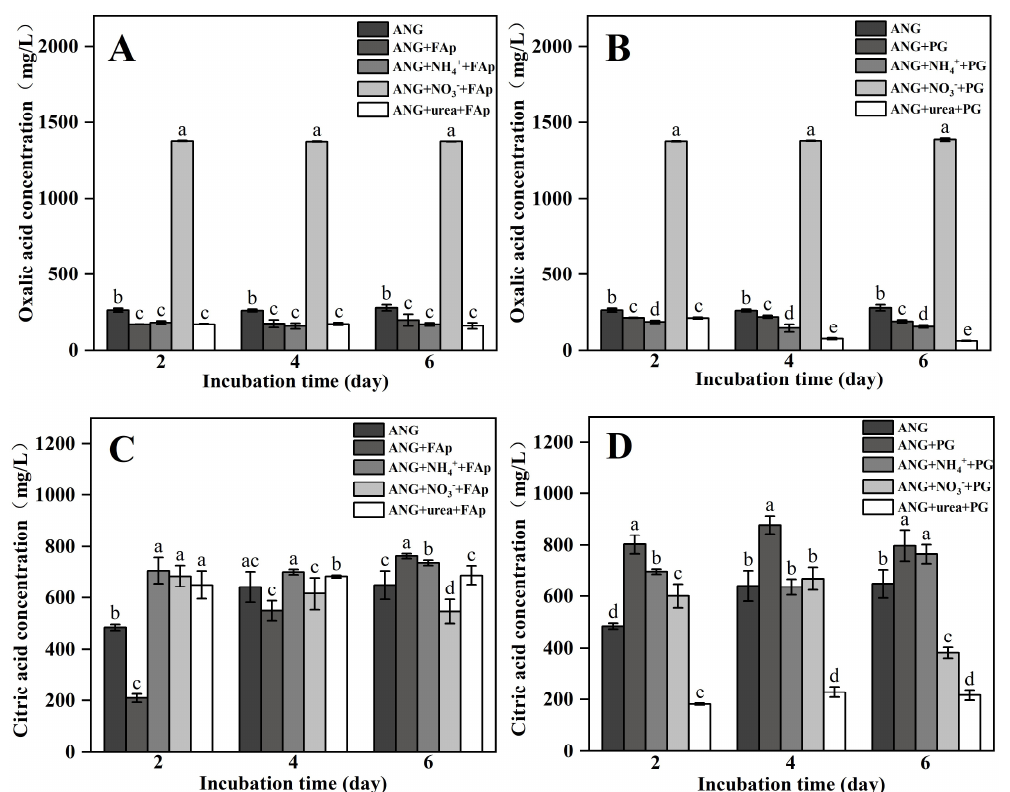
Figure 3. The secretion of oxalic acid and citric acid by ANG in the FAp ( A , C ) and PG ( B , D ) treatments during the incubation time (2, 4, and 6 days). The error bars represent the standard deviations of three replicates. The different lower-case letters indicate a significant difference between the treatments ( p < 0.05). The significant differences among the treatments were identified by Tukey test ( p < 0.05) via one-way ANOVA.